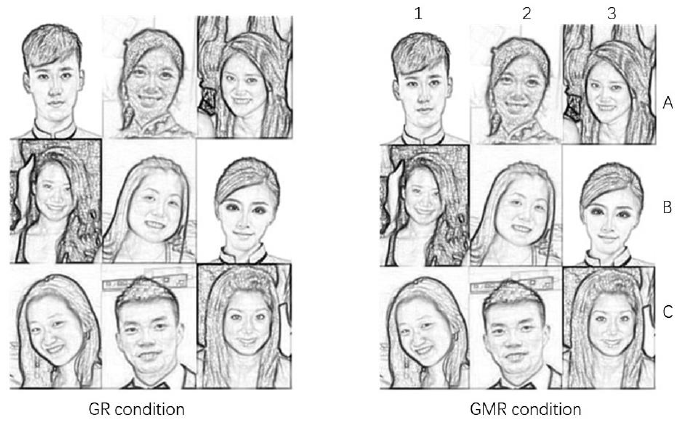
Figure 2. Example photo stimuli for Study II.